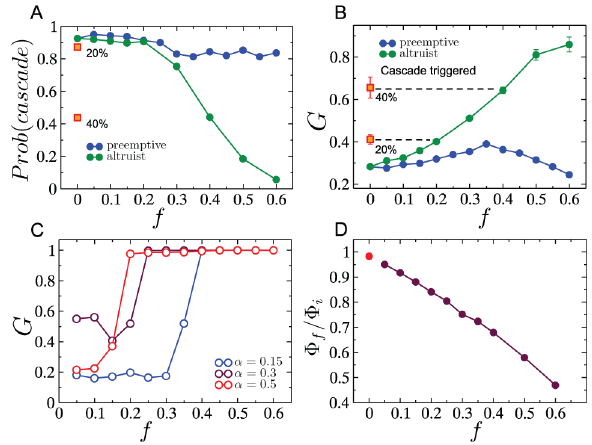
Figure 10. Increasing the resilience of the network by introducing altruist nodes. (A) Probability that a cascade is triggered for an altruist/preemptively removed fraction f . The orange squares indicated the probability of cascade when no nodes (other than the initial cascade-triggering node) are removed, but when the current per source is reduced by 20% (upper square) or 80% (lower square) immediately after the initial node removal. (B) The fractional size of the surviving giant component G when a cascade is triggered, as a function of the altruist/preemptively-removed node fraction. Also shown are the results when the current per source is reduced by 20% (upper square) or 80% (lower square) immediately after the initial node removal, which coincide with the f ~ 0 : 2 and f ~ 0 : 8 results respectively for altruistic node removal. (C) Similar to (B), but for the cases where a cascade is not triggered. (D) The ratio of the effective throughput (defined in text) of the surviving giant component and the throughput of the original network as a function of the altruist node fraction. The red circle corresponds to the case when there are no altruist nodes. Network parameters for all these plots are: N ~ 1500 , S k T ~ 6 : 0 , and a ~ 0 : 15 for results shown in (A),(B) and (D).